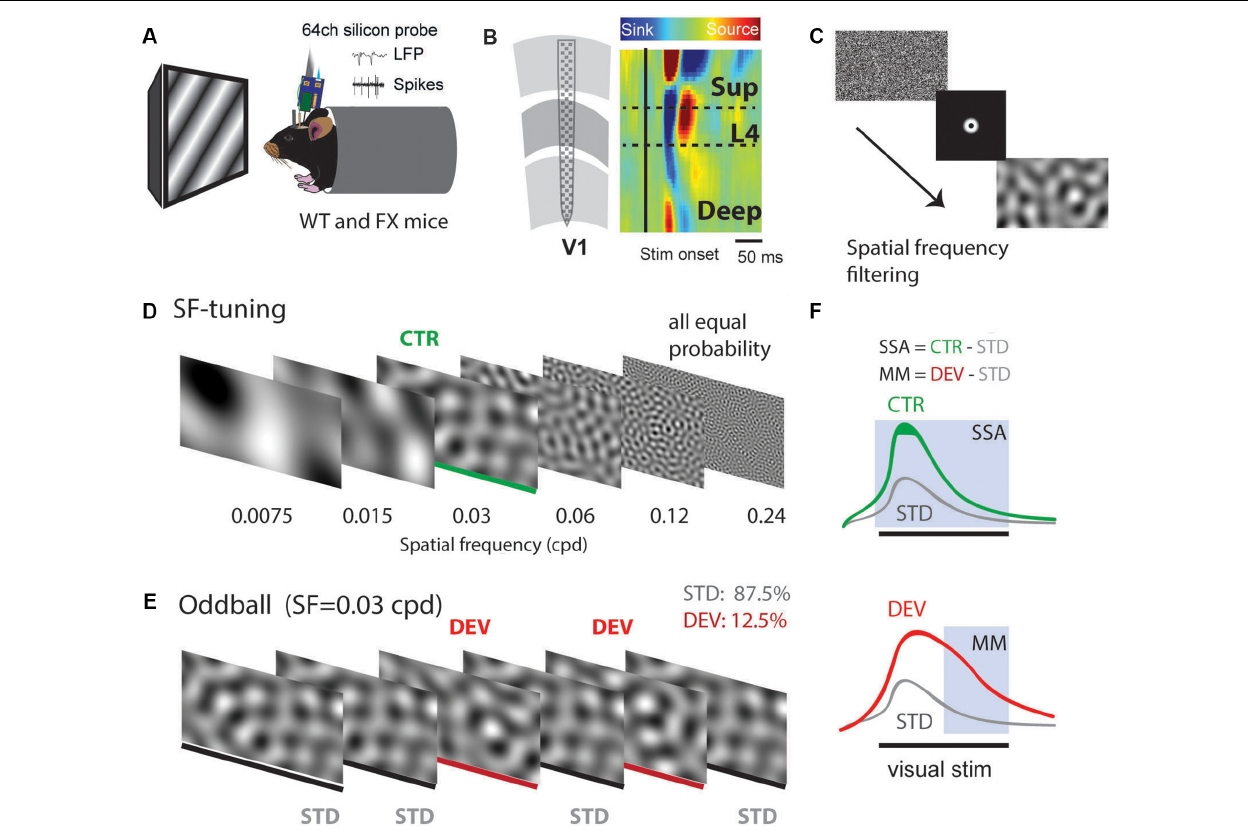
FIGURE 1 | A visual oddball paradigm with all the stimuli containing the same low-level features [spatial frequency (SF)] but different global SF patterns and expectancy. (A) In vivo extracellular silicon probe recordings in V1 of head-fixed mice. (B) Schematic of a 64-channel silicon probe spanning the whole cortical depth and an example of current source density (CSD) heatmap. (C) To generate visual stimuli, we performed SF filtering of white noise. (D) We used six different non-overlapping SF bands from 7.5E-3 to 0.24 cpd for spatial frequency tuning (many standards control). Stimuli were presented in a pseudorandom order and had equal probability. (E) The oddball sequence contained stimuli of the same SF (0.03 cpd) that only differ in their probability and overall texture. Standard (STD) and deviant (DEV) stimuli were presented with a probability of 0.875 and 0.125, respectively. (F) Given that STD and DEV have the same low-level features (SF), we computed a neuronal mismatch (MM) response by comparing late (0.3–0.5 s) responses of STD and DEV. Stimulus-specific adaptation (SSA) was obtained by comparing STD and CTR. Since both STD and DEV had the same SF, neural population activity is expected to be adapted during the